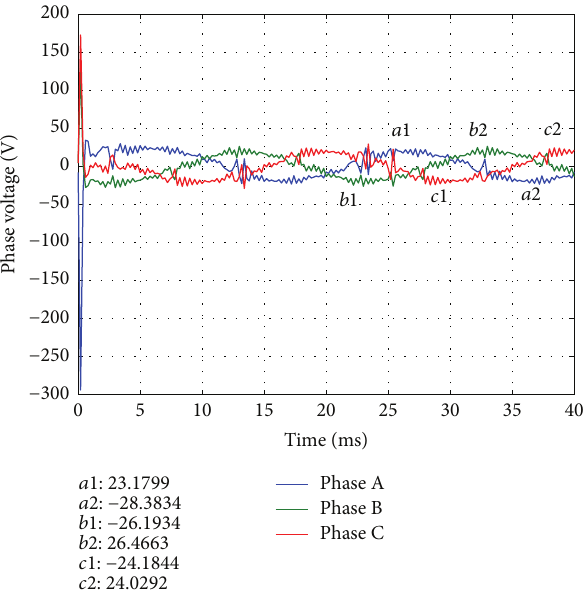
Figure 8: Phase voltage waves under normal condition.